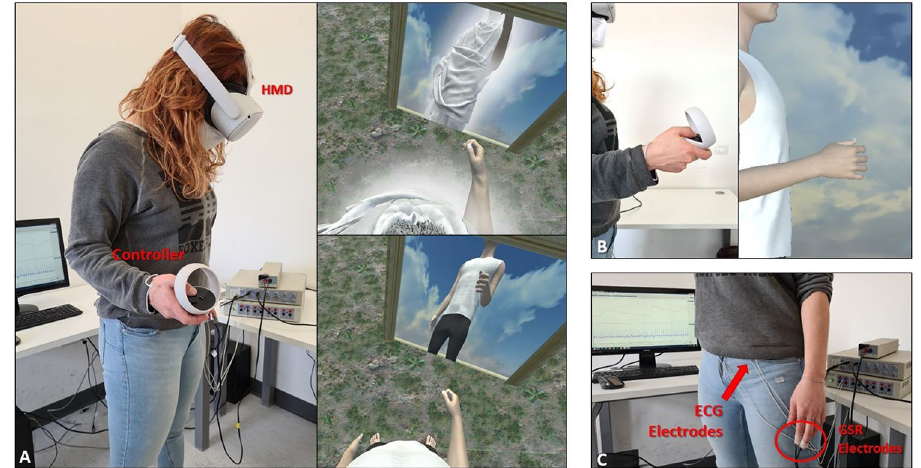
Figure 2. A schematic representation of the experimental setup. ( A ) The participant observing from 1PP the God-avatar (upper part) or the Normotype-control avatar (lower part) and the avatar reflection in the virtual mirror. The participant has provided consent for the publication of the image. ( B ) Right-arm motion tracking: the participant’s movements were congruently mapped, in terms of space and time, on the avatar right arm. ( C ) Snapshot of physiological tools used to record SCR and HR in Study 1.